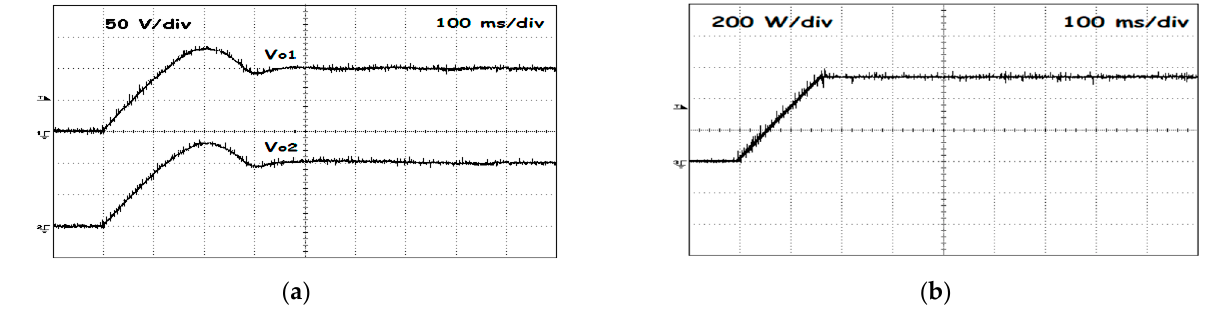
Figure 13. Obtained experimental waveforms for the tests in which 700 W/m 2 (irradiance) and 25 °C (ambient temperature) during the connection of the system were defined: ( a ) DC/DC output voltages, ( b ) generated PV power.